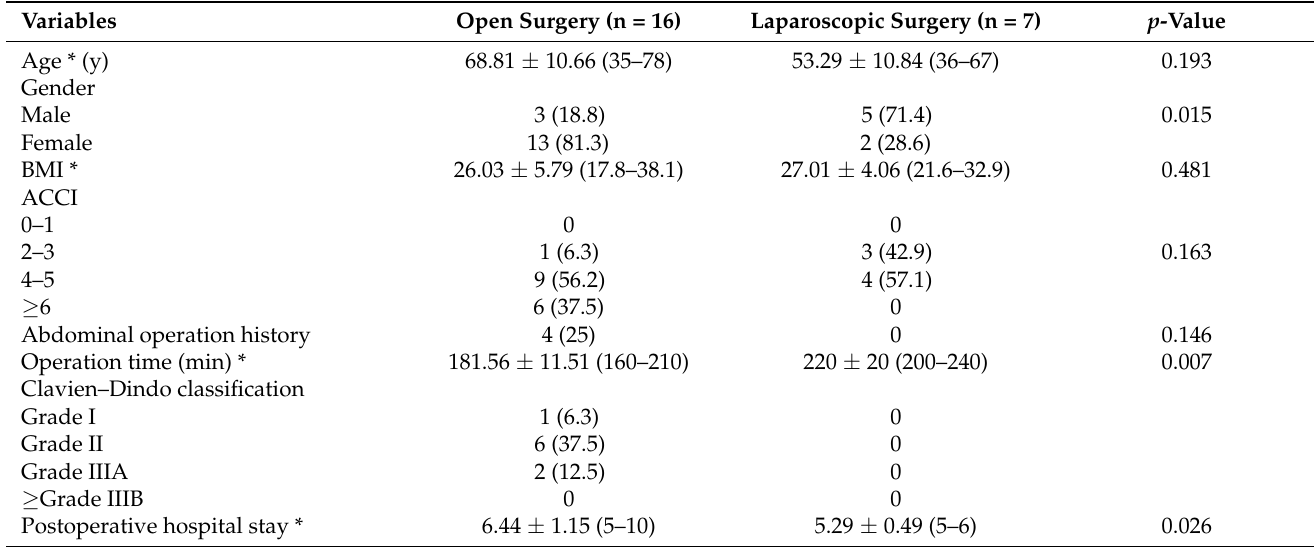
Table 5. Comparison of clinical and operative outcomes between laparoscopic and open surgery for T3 proximal transverse colon